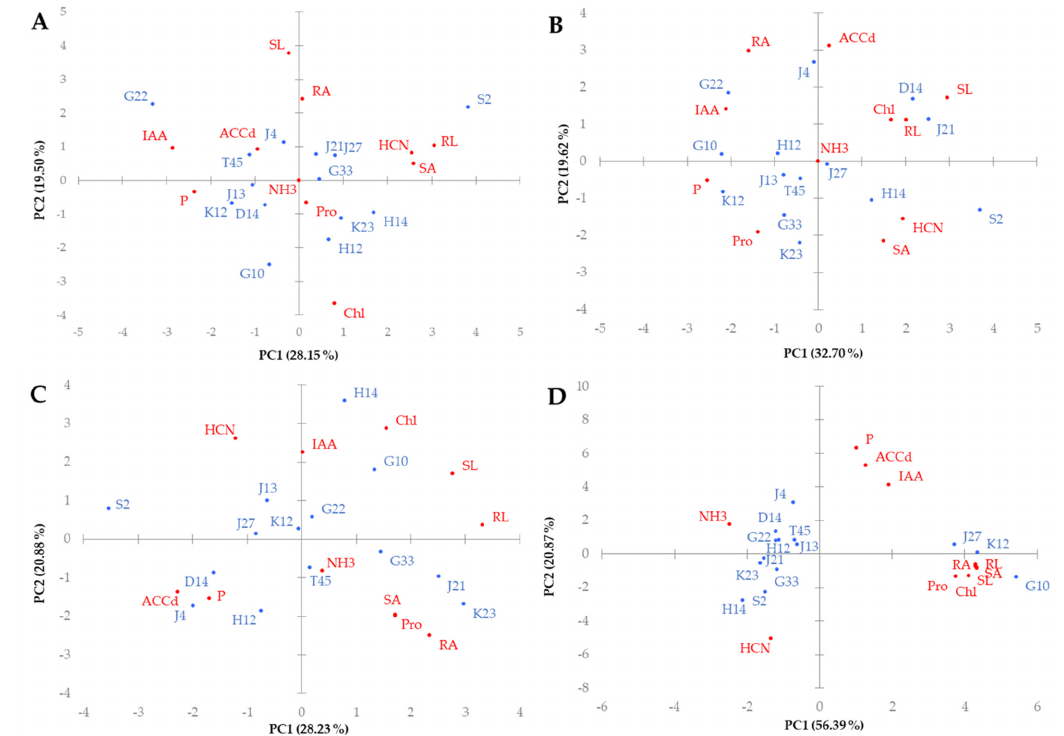
Figure 8. Biplot obtained from the principal component analysis (PCA) on the dataset of in vitro and in planta results (loadings, in red) recorded for actinomycete strains (scores, in blue) under different salt stress concentrations ( A —0.25 M NaCl L − 1 , B —0.5 M NaCl L − 1 , C —0.75 M NaCl L − 1 , and D —1 M NaCl L − 1 ). In the figure: ACCd, 1-aminocyclopropane-1- carboxylate deaminase activity; Chl, total chlorophyll; SL, length of shoots; RL, length of roots; RA, ash-free dry weight of roots; SA, ash-free dry weight of shoots; Pro, proline; P, phosphate solubilization; IAA, indole-3-acetic acid.